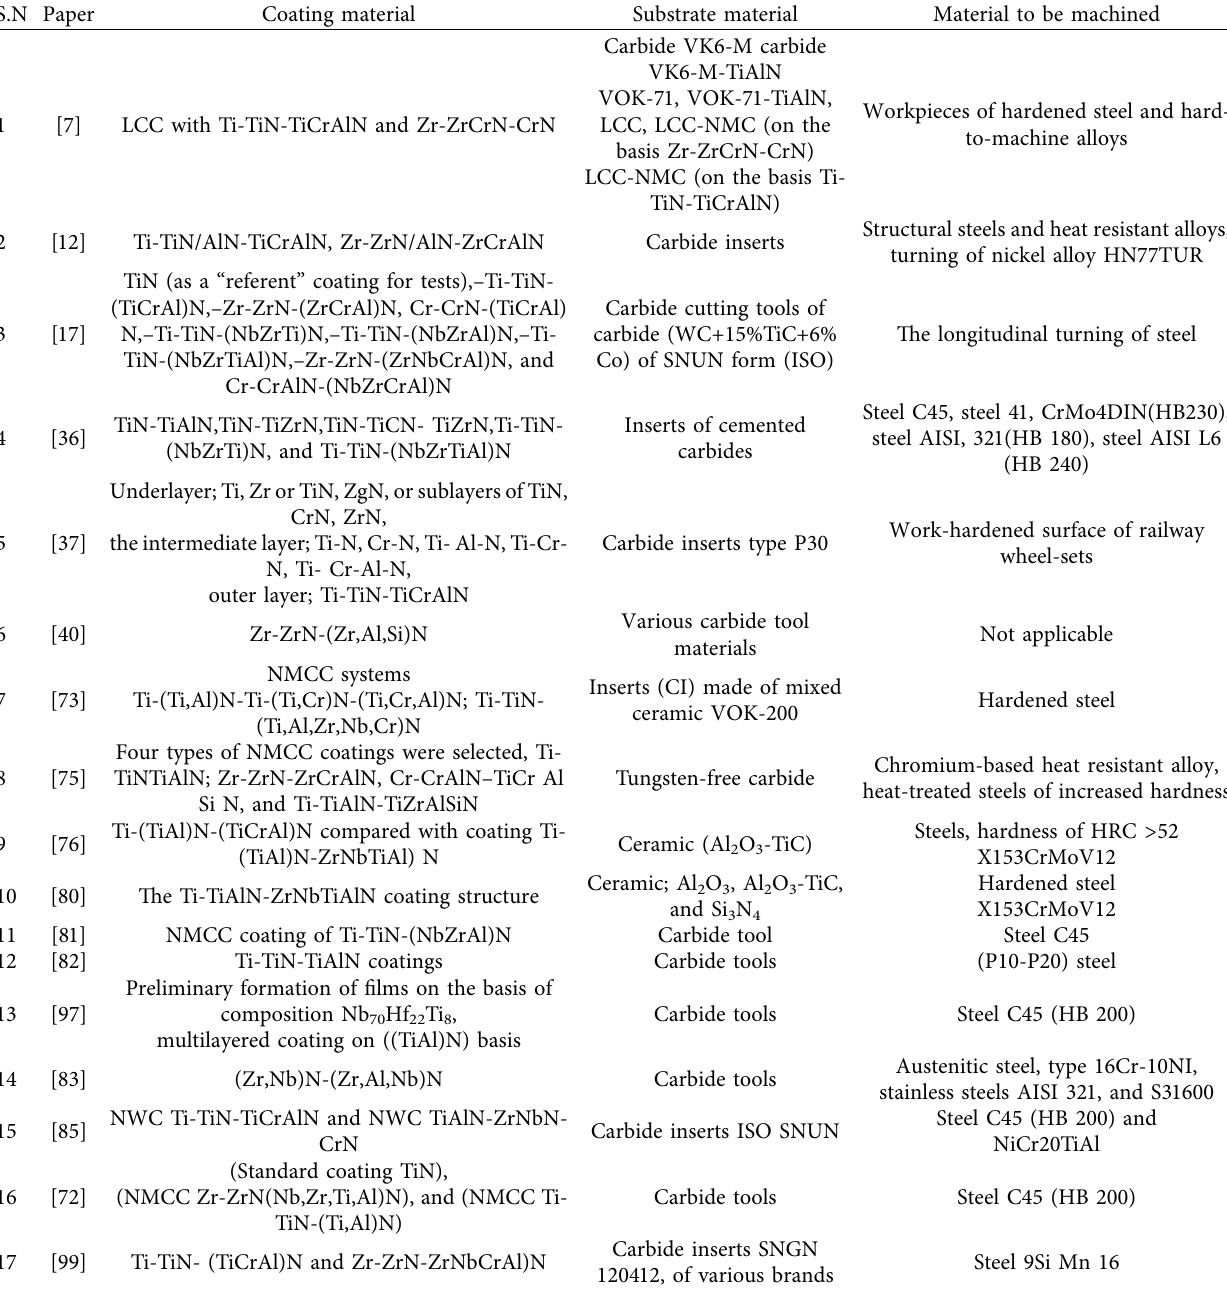
Table 2: Synthesis of the coating materials, substrate, and work materials of the reviewed papers. S.N Paper Coating